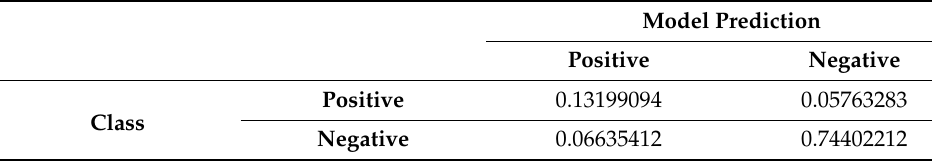
Table 9. Confusion matrix (Improved U-Net #2/ large number of particles).